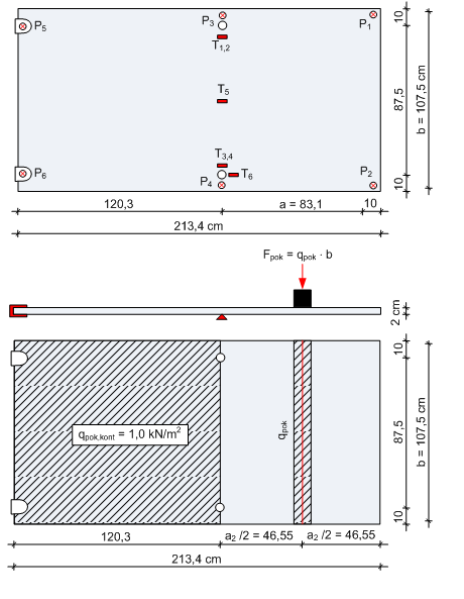
Figure 6. Positions of measurement points (up) and load distribution (down).